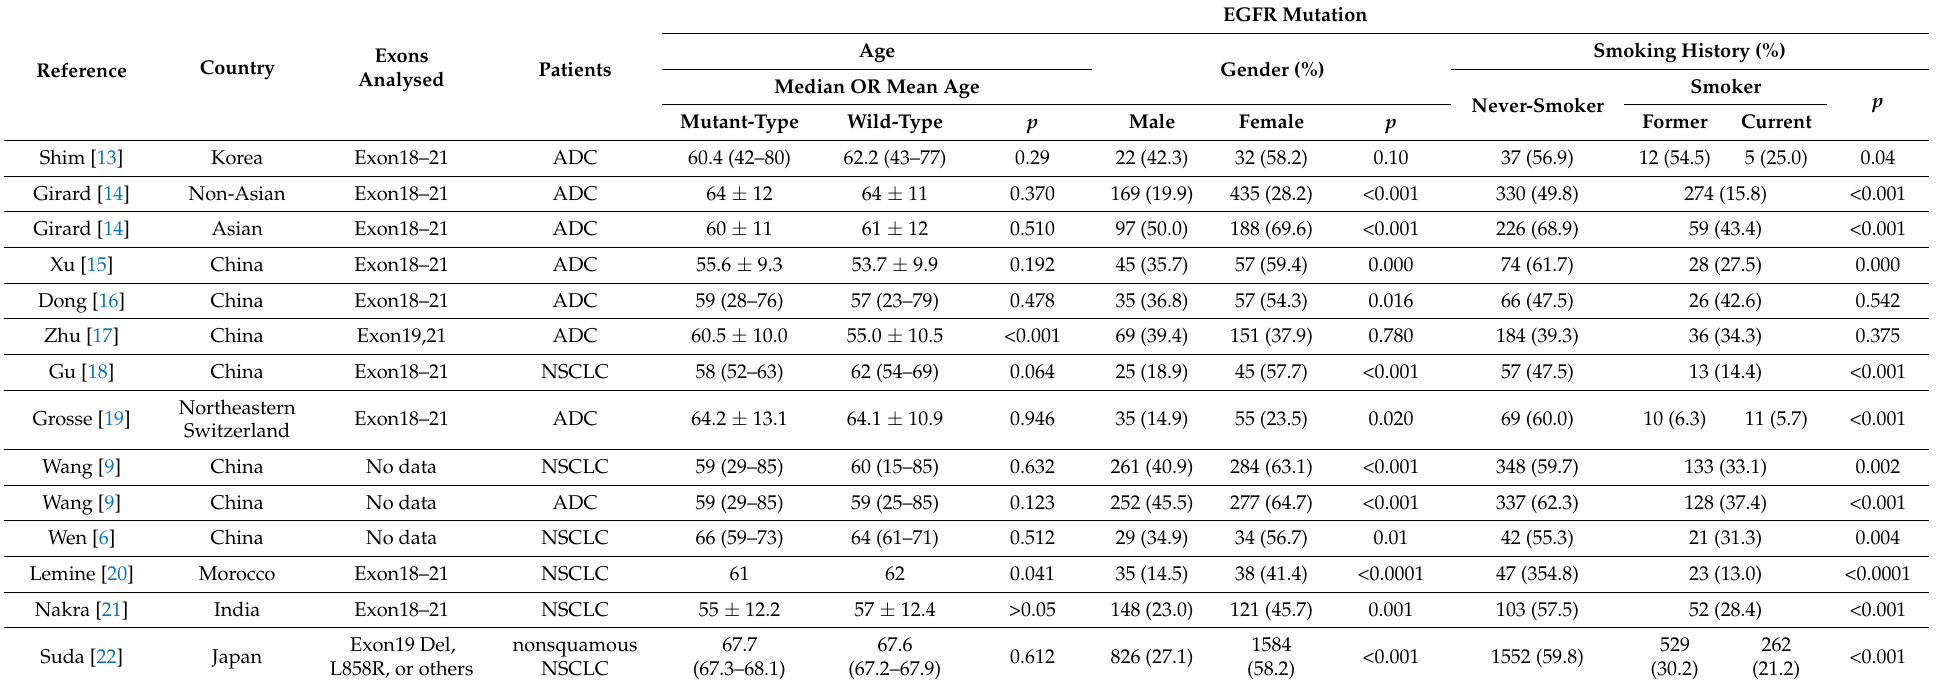
Table 1. Key studies of demographic characteristics and EGFR mutation rates in NSCLC